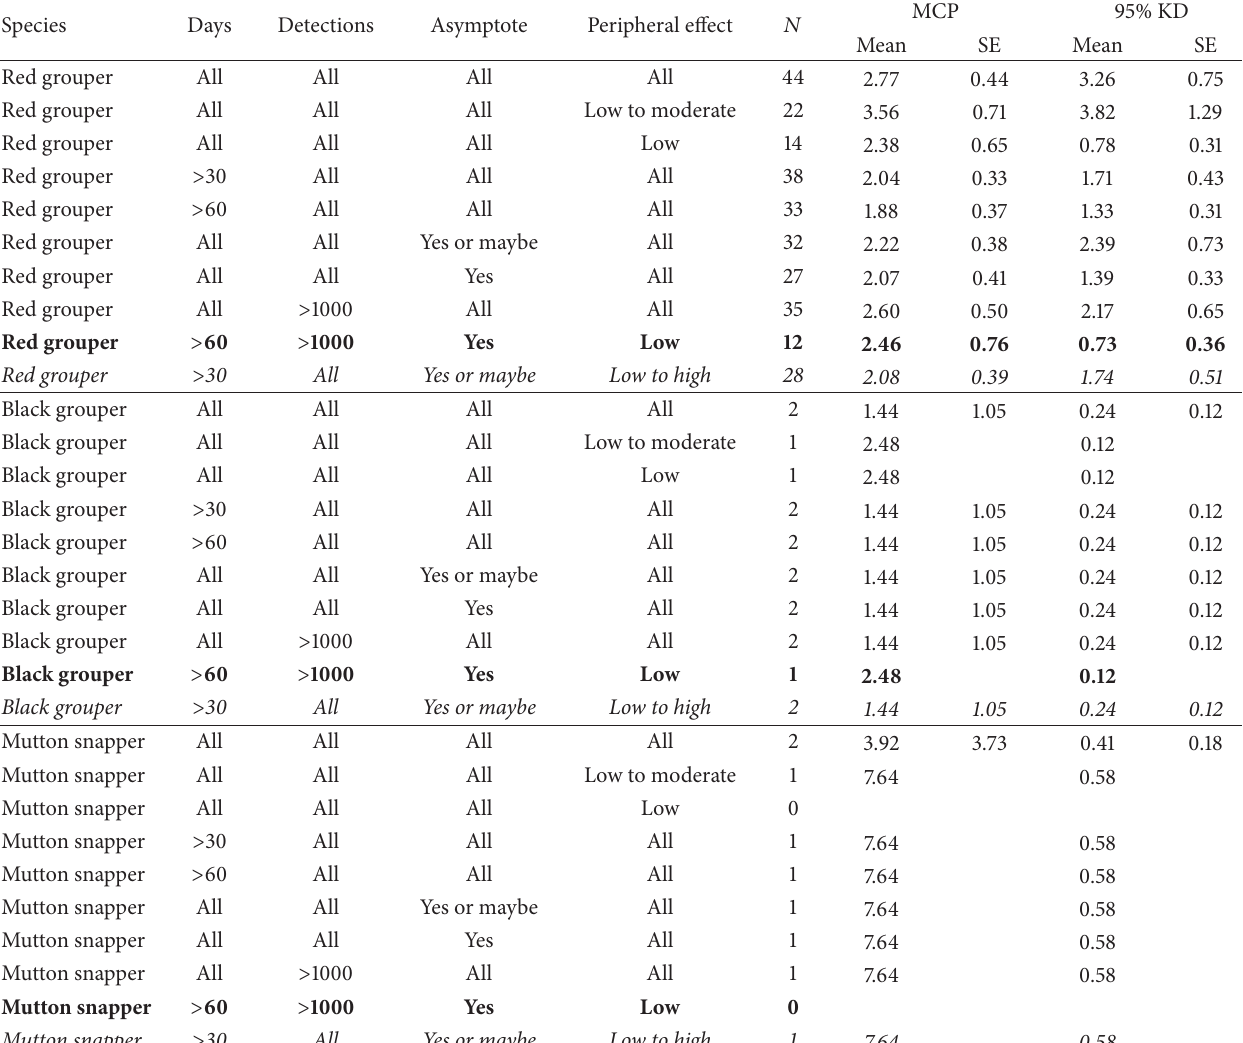
Table 4: Availability and sensitivity of minimum convex polygon (MCP) and 95% kernel density (KD) home range (km 2 ) estimates from acoustically tracked reef fish in Dry Tortugas, Florida ( from [10] ) to filtering